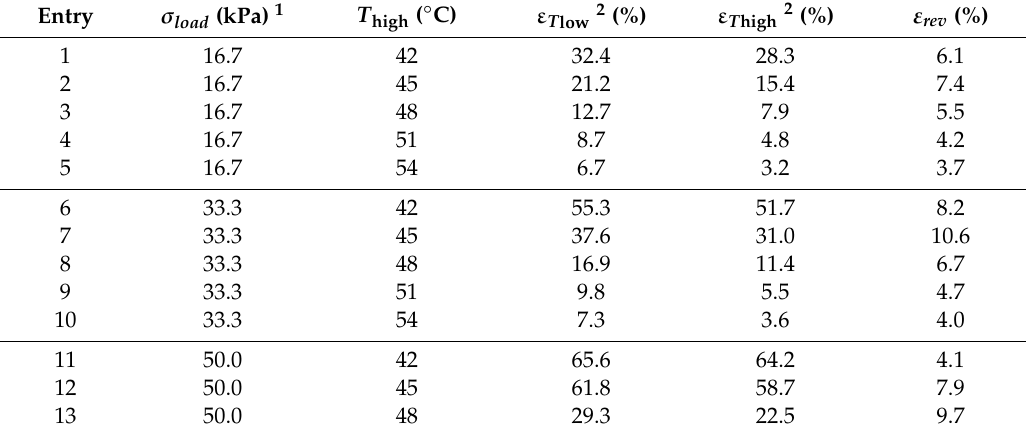
Table 6. Influence of loading stress σ load during thermomechanical treatment on bidirectional actuation of the PEUU foam under load-free conditions ( T low = 20 °C).